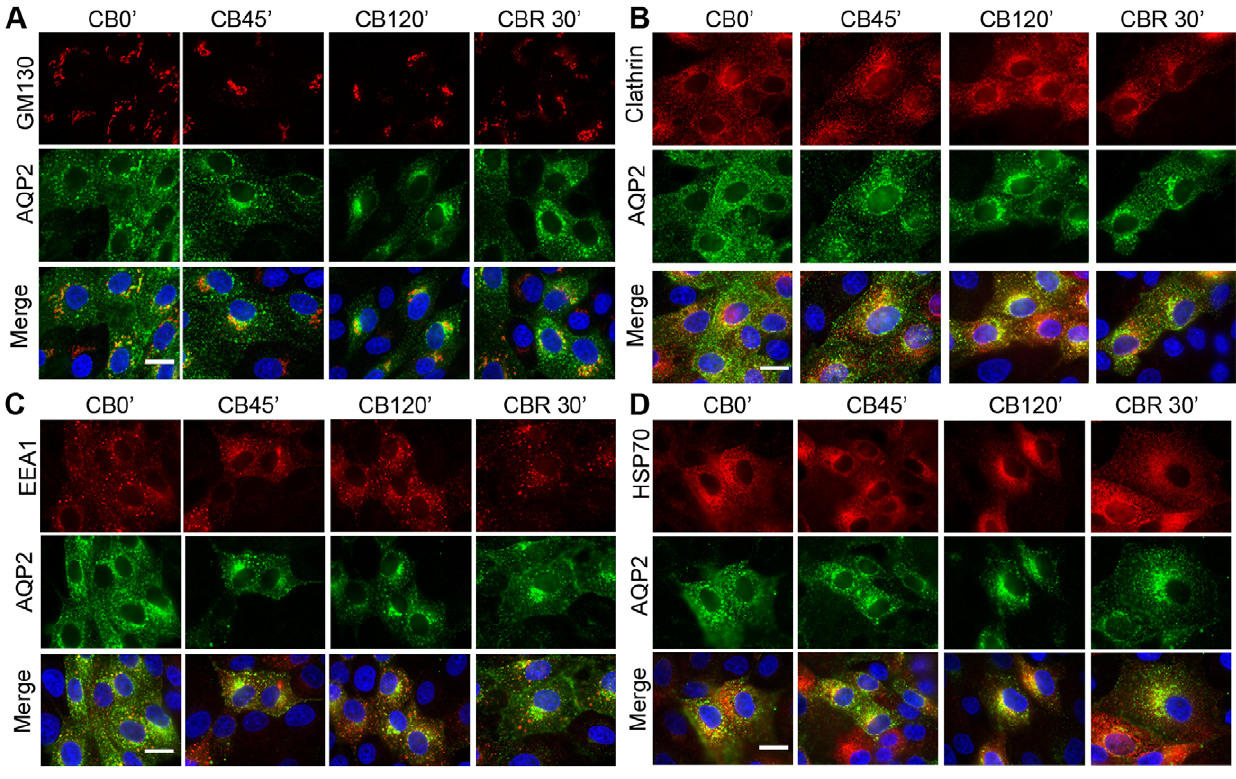
Figure 6. Association of AQP2 and cellular compartment markers during the dynamic process of cold block and cold block release. The association of subcellular compartment markers with AQP2 during the cold block and subsequent release was investigated. GM130, clathrin, EEA1, and HSP/HSC70, were co-stained with AQP2 (A, B, C, D). Panel A, GM130 staining also overlaps with AQP2 in the perinuclear patch but not after release of the cold block. In panel B, clathrin appeared to colocalize mostly with AQP2 during the development of the perinuclear patch and redistribution after cold block release. Panel C, EEA staining was colocalized with AQP2 at the early stage of endocytosis, and was partially associated with the perinuclear patch. After CBR at 37 u C, a few large EEA/AQP2 positive structures appeared, but most AQP2 was not associated with EEA. Panel D, HSP/HSC70 partially colocalized with AQP2 during the formation of the perinuclear patch, but not during AQP2 redistribution after cold block release. Scale bar=20 m m.